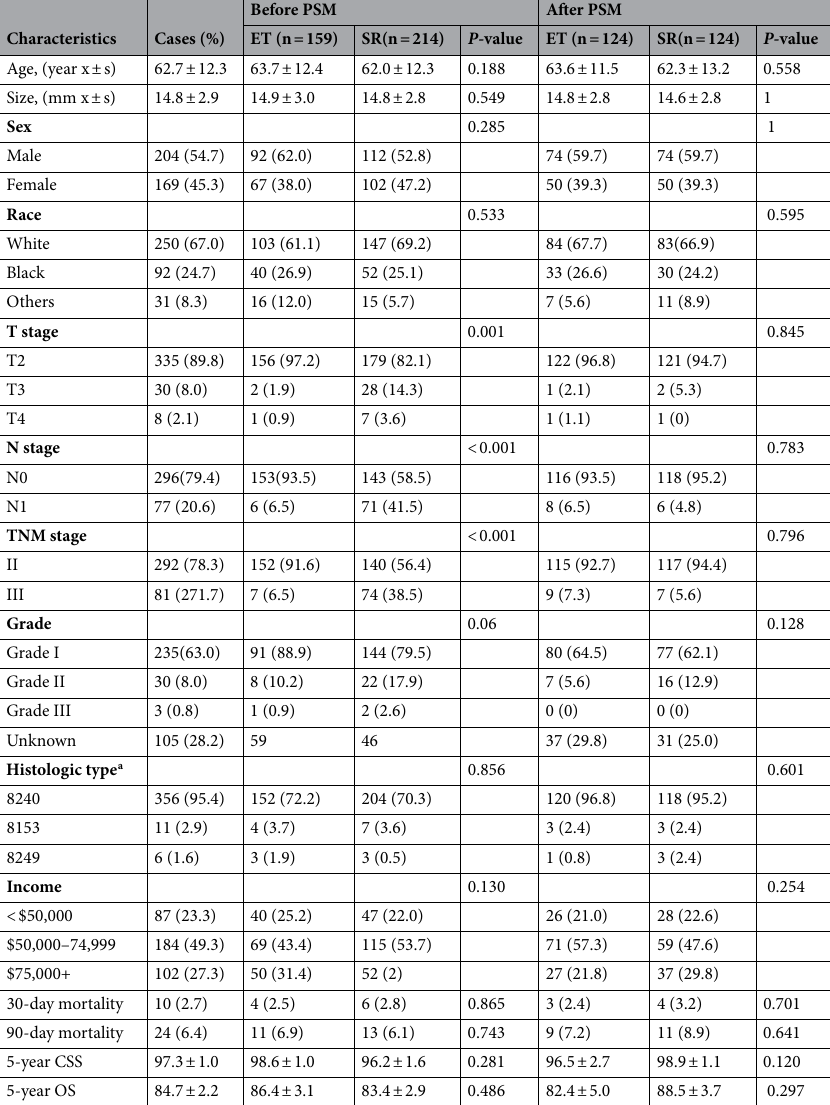
Table 1. Distribution profiles of the clinicopathologic factors of the patients in the endoscopic treatment group and surgical resection group before and after PSM. ET endoscopic treatment, SR surgical resection, PSM propensity score matching, WHO World Health Organization, Grade I well differentiated, Grade II moderately differentiated, Grade III poorly differentiated or undifferentiated. a International Classification of Diseases for Oncology, 3rd Edition (ICD-O-3): 8240, Carcinoid tumor; 8153, Gastrinoma, 8249, Atypical Carcinoid